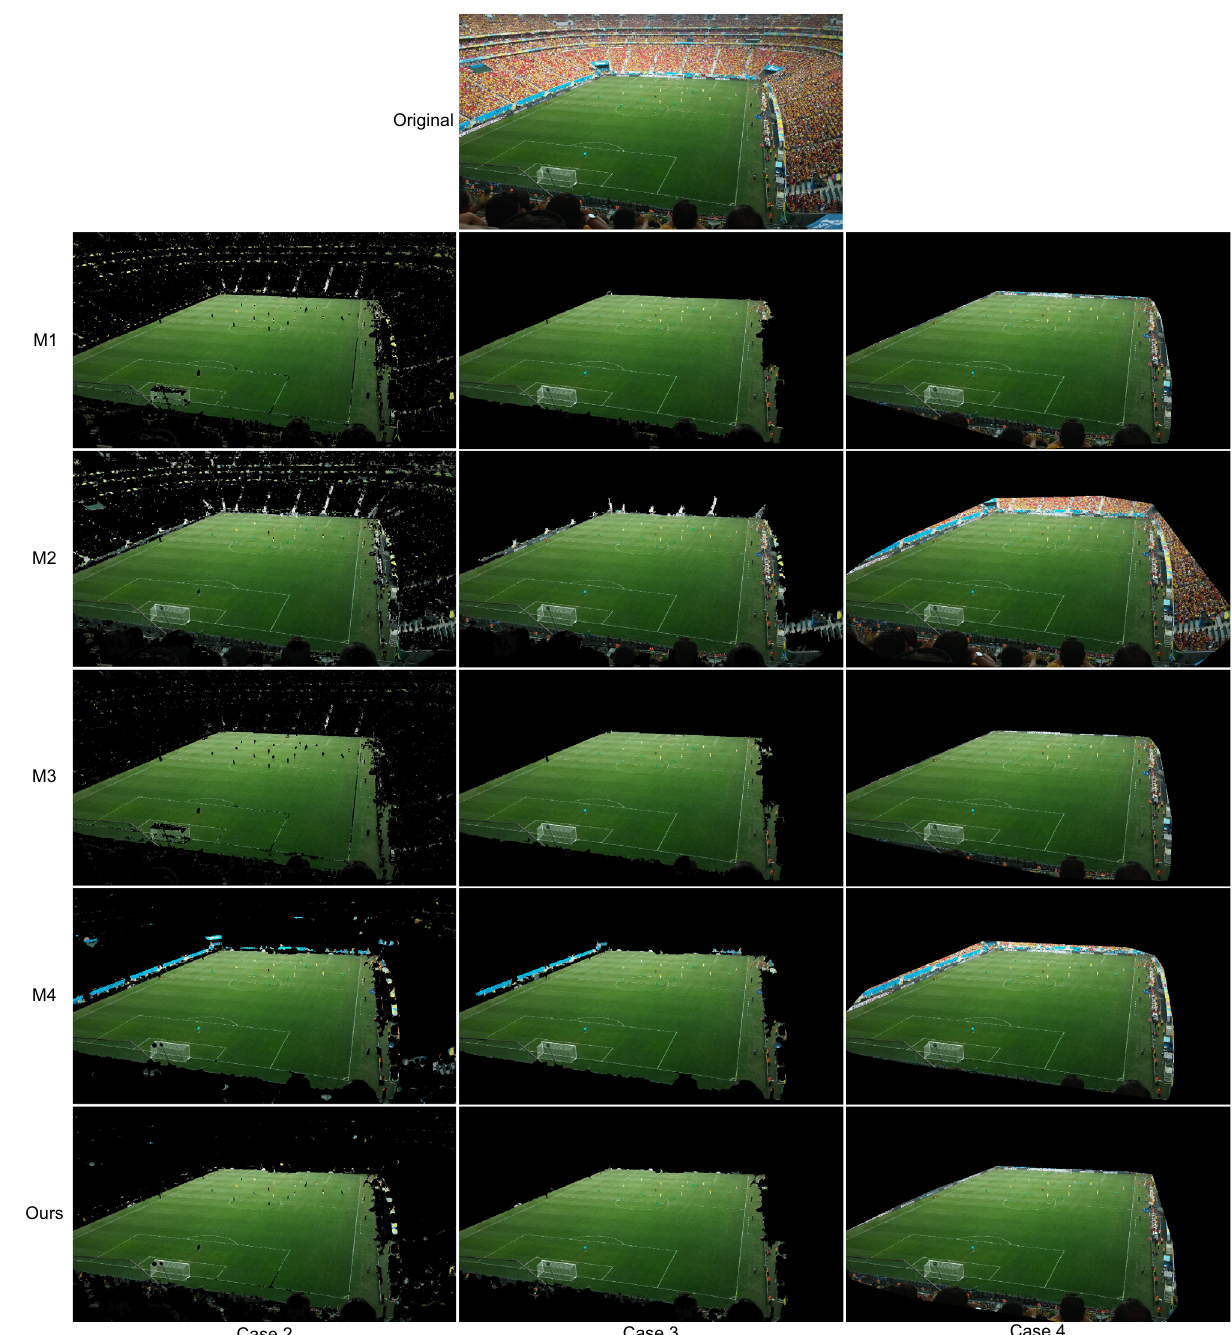
Figure 13. Results obtained in an image with cyan billboards. Original image from 46